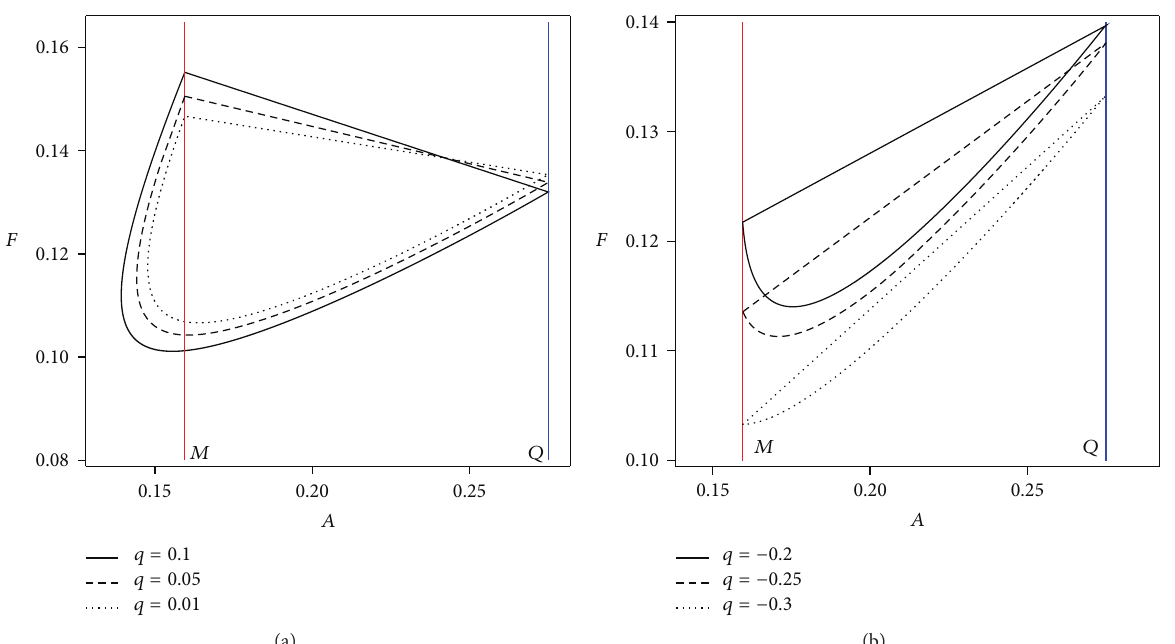
Figure7:Transitionoftheorder-1periodicsolutionofsystem(1).Theline 𝑀 andtheline 𝑄 representimpulsivesetandphaseset,respectively. Black cures show the order-1 periodic of system (1).